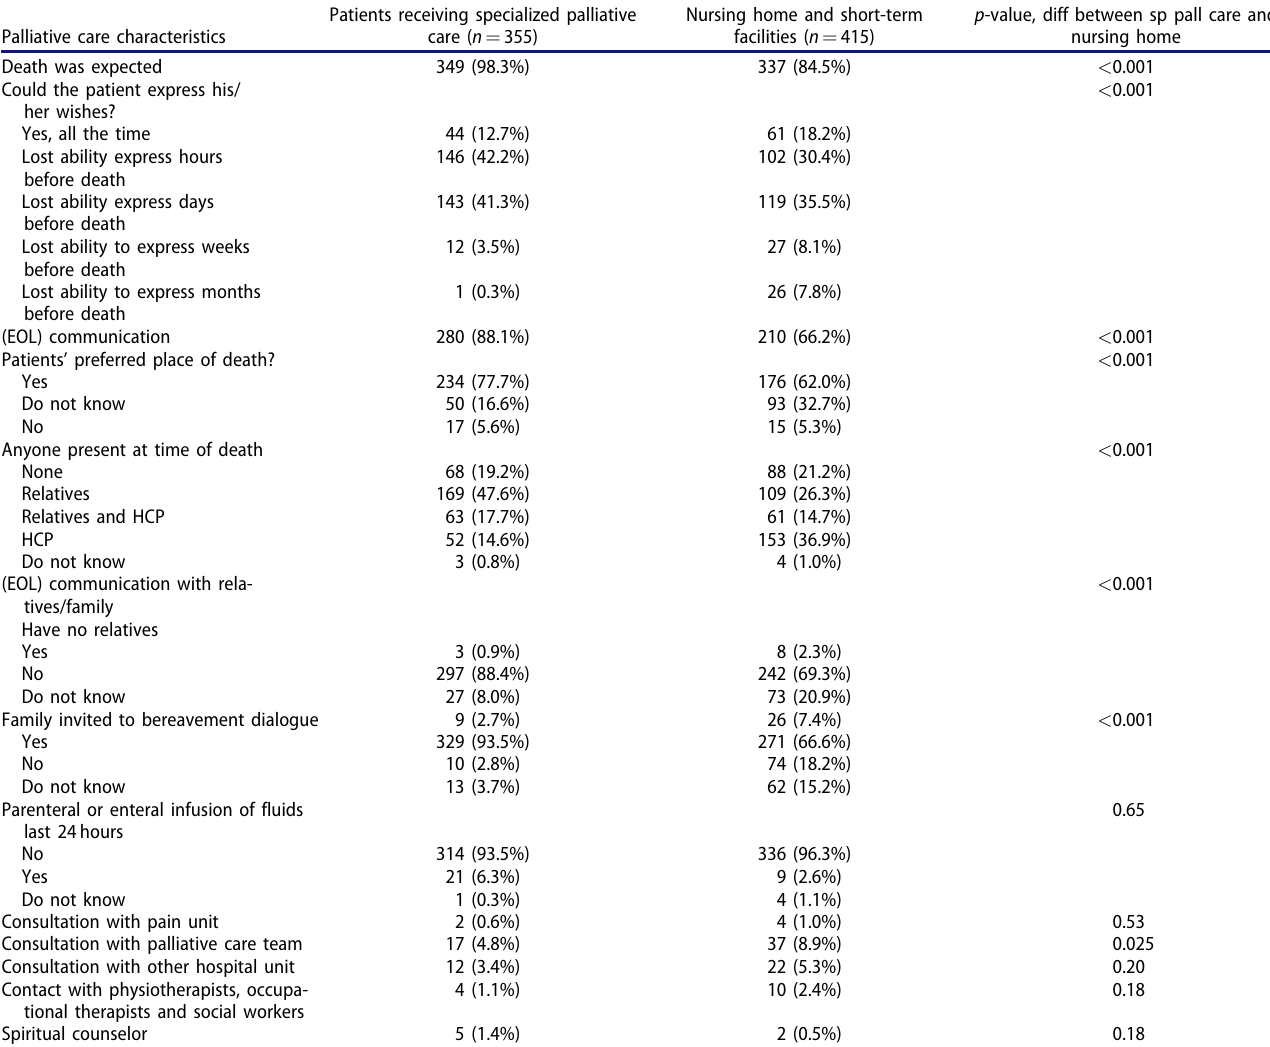
Table 3. Characteristics of palliative care registered in specialized palliative care and in nursing homes. (chi-square). Palliative care